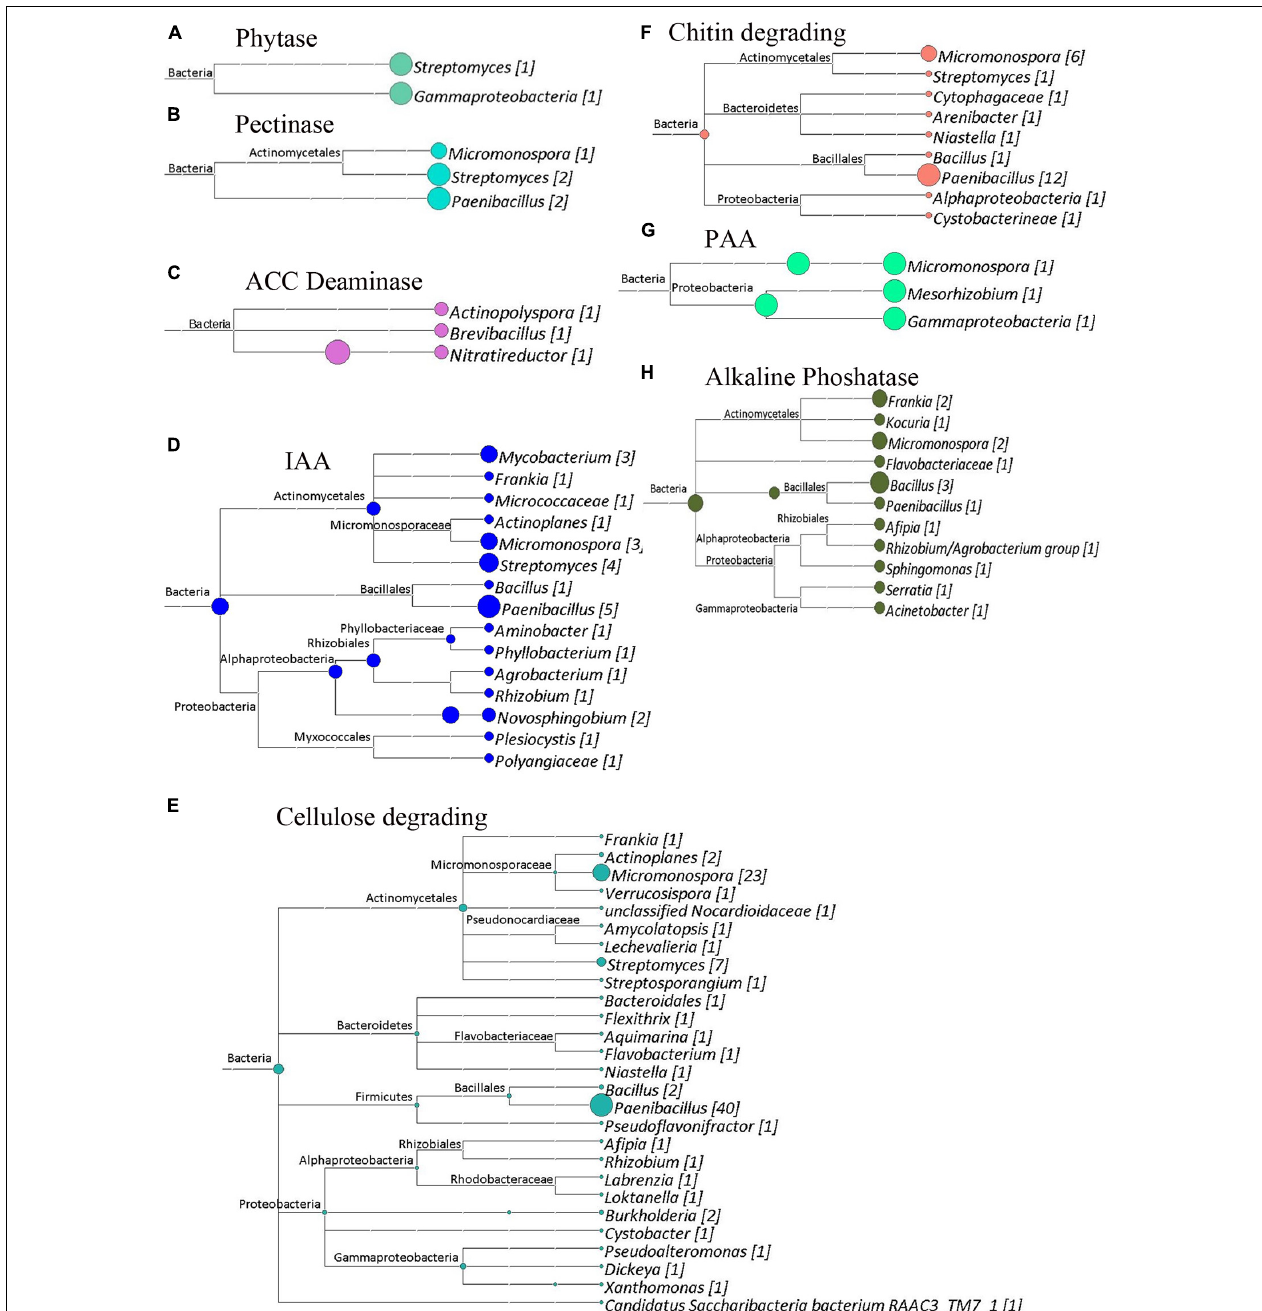
FIGURE 8 | Cladograms of functional genes from Site 2 (Sidi Bouzid), that were produced by the LCA Algorithm in MEGAN (Version 5). The sizes of colored circles represent that relative contribution of a taxa to the functional genes analyzed in a given cladogram. Numbers in Brackets represent that number of genes that annotated to a given taxon for that set of genes. (A) Phytase genes. Total genes identified, 8. (B) Pectinase enzymes. Total genes identified, 5. (C) ACC deaminase genes. Total genes identified, 3. (D) Potential indole acetic acid biosynthesis genes. Total genes identified, 27. (E) Cellulose degrading enzymes. Total genes identified, 97. (F) Chitin degrading enzymes. Total genes identified, 25. (G) Potential phenyl acetic acid biosynthesis genes. Total genes identified, 3. (H) Alkaline phosphatase genes. Total genes identified,